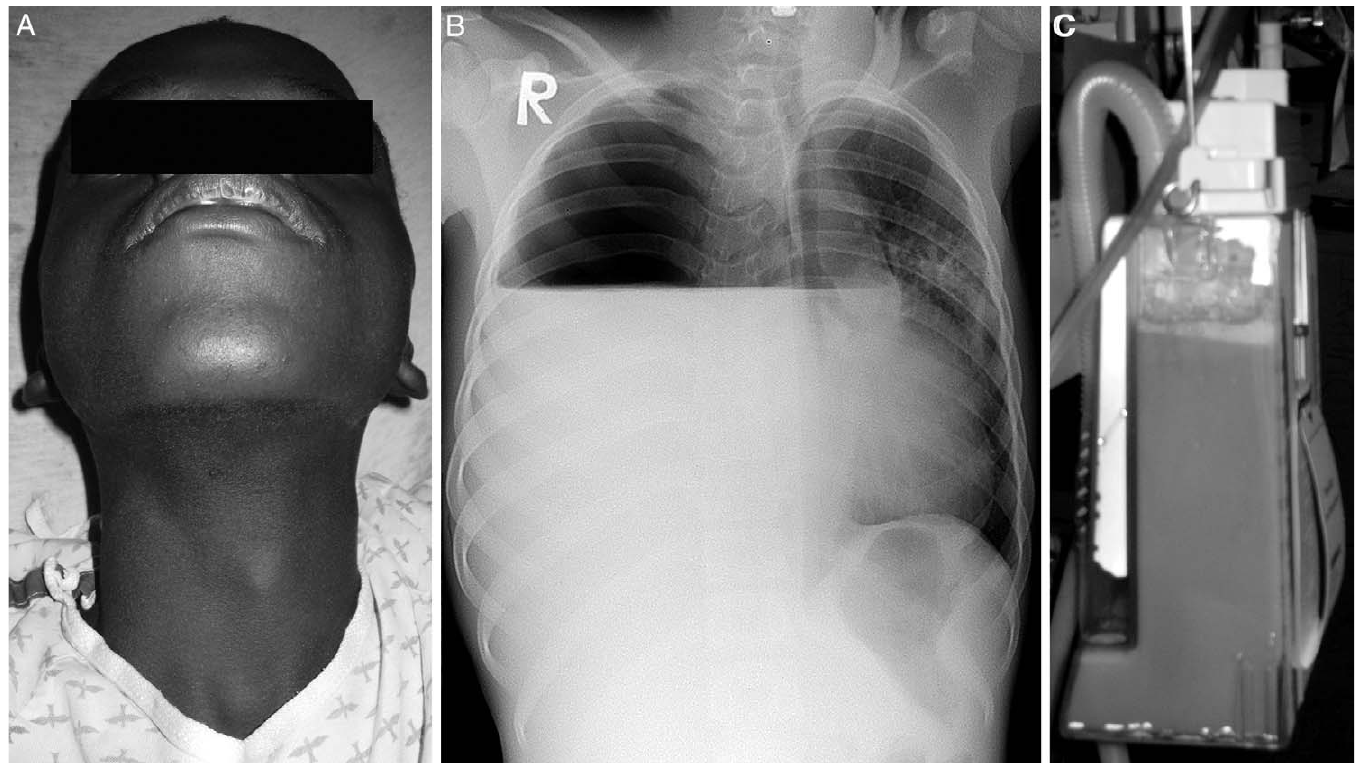
Figure 2. A, A 17-year-old male referred from the tuberculosis (TB) clinic for shortness of breath with evidence of tracheal deviation on examination of neck. B, Chest radiograph of 17-year-old male referred from TB clinic for shortness of breath reveals right-sided air-fluid level with pneumothorax and mediastinal shift. C, Purulent drainage from tube thoracostomy of patient with presumed TB effusion and pneumothorax. (All patient images taken with permission of patient or accompanying guardian.)